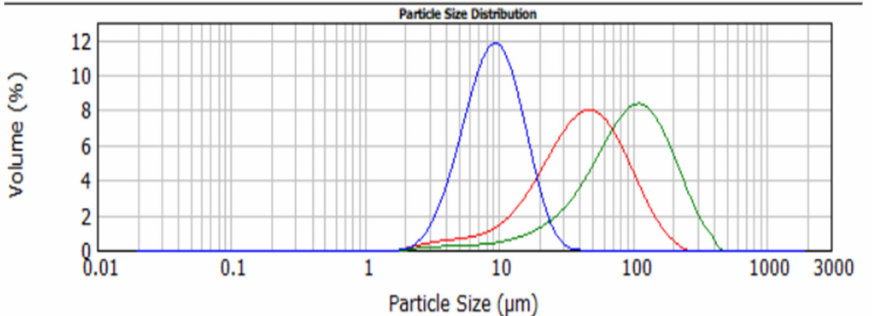
Figure 5. Particle size distribution of CS_1.0: CS_1.0_10 (blue), CS_1.0_40 (red) and CS_1.0_100